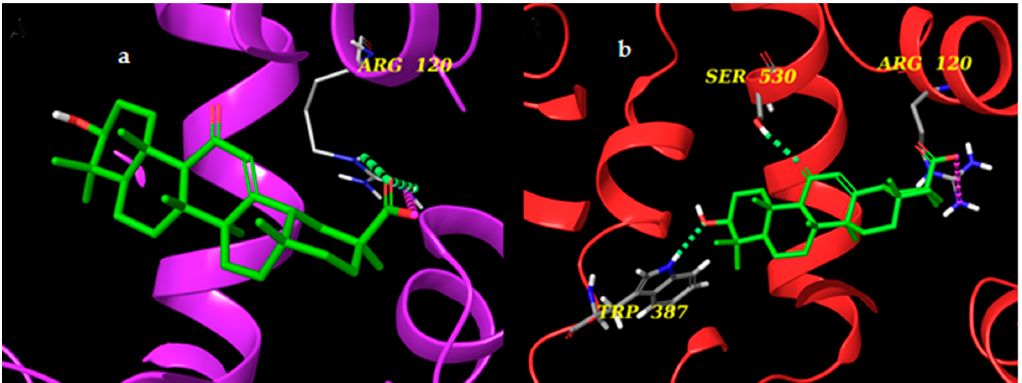
Figure 11. ( a ) 3D models of AG (colored by atom types: C green, O red, polar H white) in the binding site of cyclooxygenase 1 (COX-1) (purple ribbons) and ( b ) cyclooxygenase 2 (COX-2) (red ribbons). Green dotted lines represent H-bonds and pink dotted lines represent salt bridges.